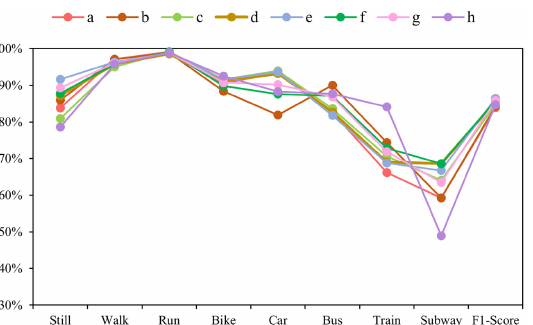
Figure 12. F1-Scores obtained on the SHL dataset using eight different sets of hyperparameters, a–h, for transportation mode